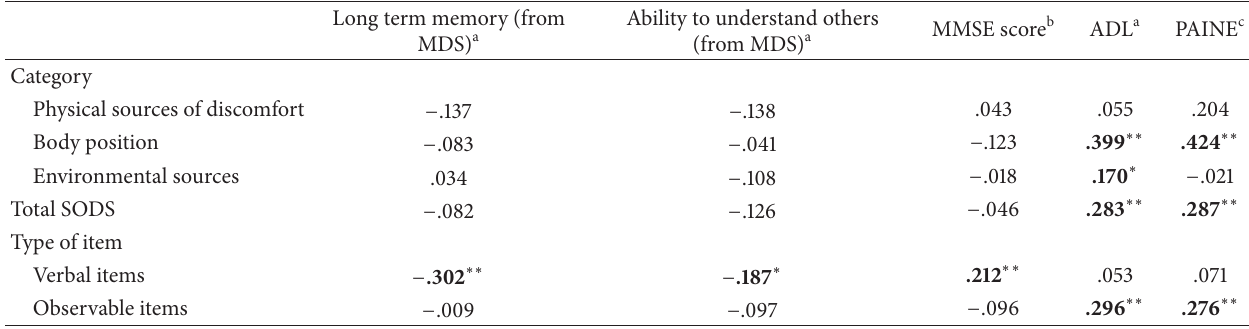
Table 3: Correlations of functional and pain variables with categories of sources of comfort and with type of SODS